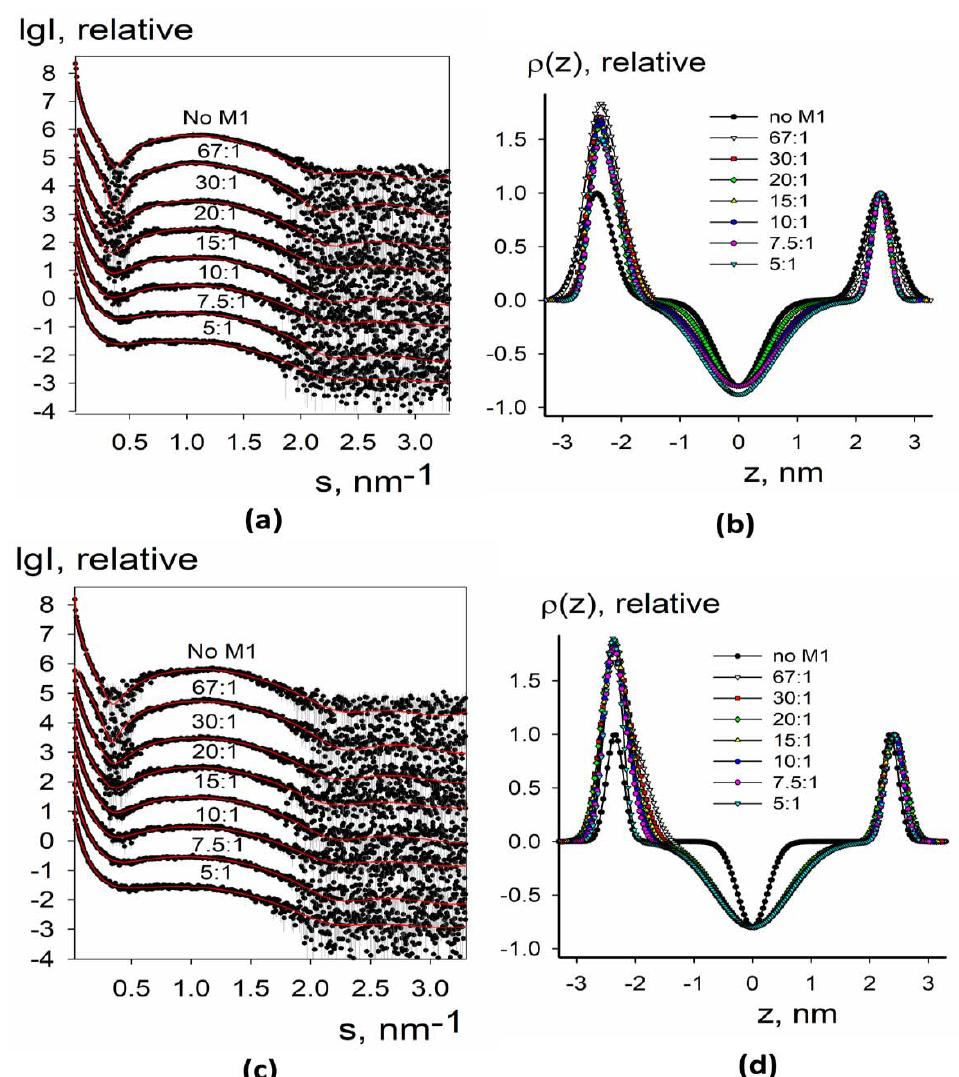
Figure 4. SAXS and BILMIX analysis of synthetic liposomes composed of 30 mol.% bPS + 10 mol.% POPC + 40 mol.% SM + 20 mol.% Chol ( a , b ) or 20 mol.% bPS + 13.3 mol.% POPC + 33.3 mol.% SM + 33.3 mol.% ( c , d ) lipid mixtures loaded with M1 protein. ( a , c ) Experimental small-angle scattering data are represented by dots with error bars. The best fits of the SAXS curves obtained by BILMIX program are shown by solid red lines. The curves are shifted by one logarithmic order for better clarity; ( b , d ) the restored electron density profiles of the lipid bilayer before (black curve) and after (color curves) loading with M1. The molar lipid/M1 ratios are the following: no M1, 67:1, 30:1, 20:1, 15:1, 10:1, 7.5:1, 5:1.